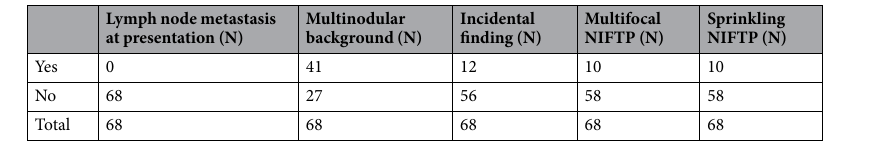
Table 2. Lymph node metastasis at presentation, multinodular background Noninvasive follicular thyroid neoplasm with papillary-like nuclear features (NIFTP), incidental NIFTP, multinodular NIFTP, sprinkling NIFTP in our case